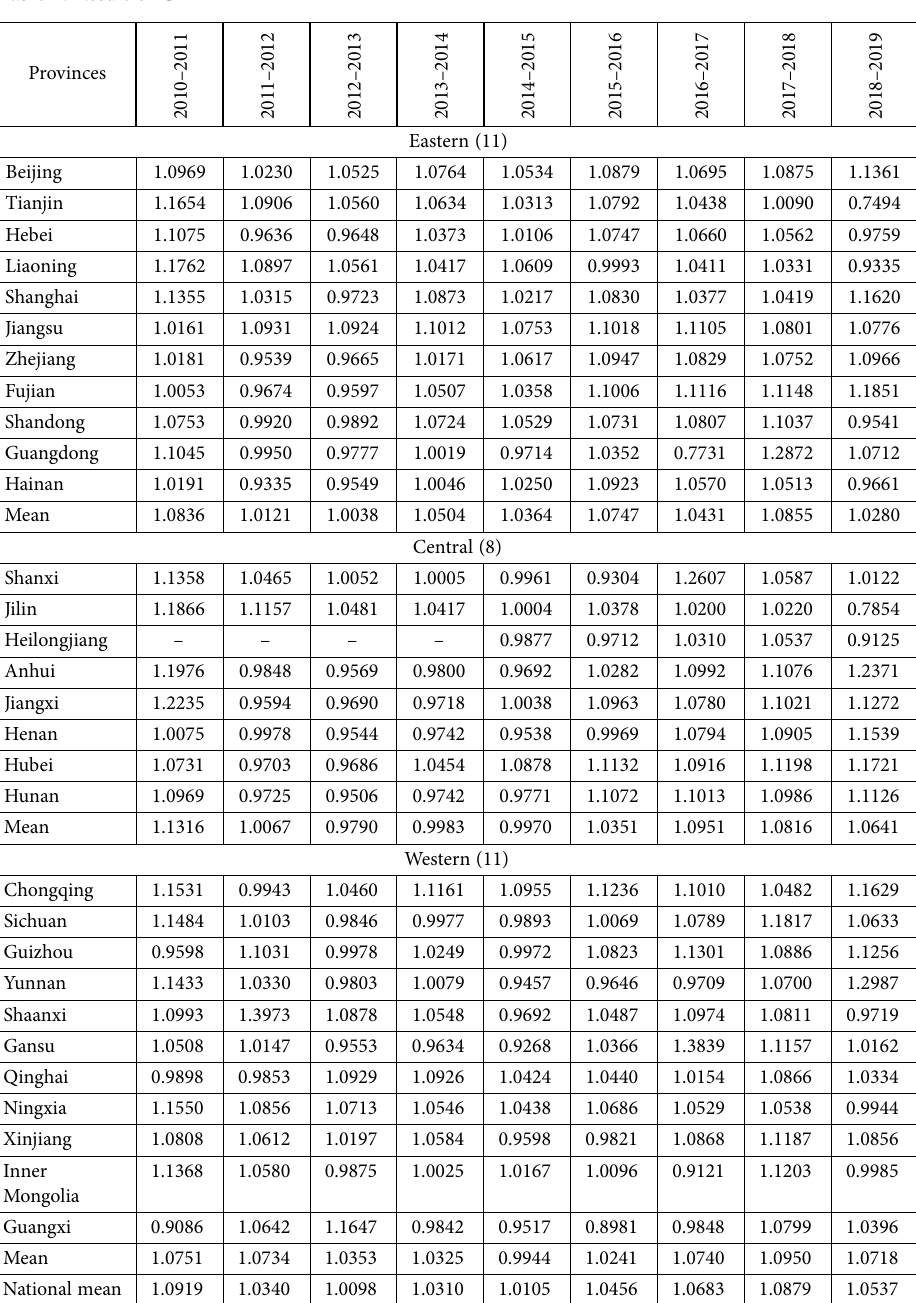
Table 4. Result of